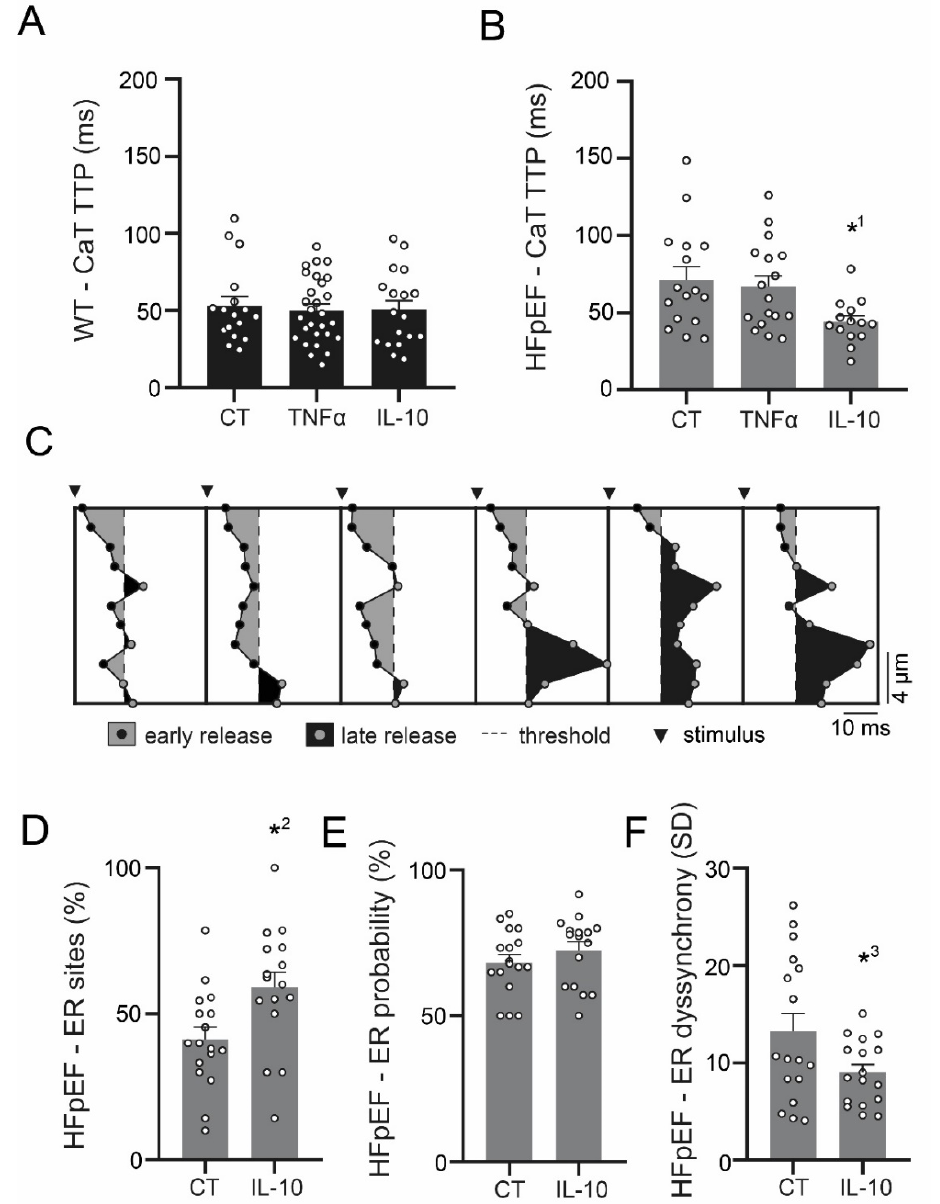
Figure 4. ( A ) CaT time-to-peak (TTP) of left atrial cardiomyocytes in WT and ( B ) HFpEF after 1 h incubation in Tyrode solution (CT), with additional TNF α or IL-10 (10 µ M, respectively). ( C ) Example visualization of early Ca 2 + release (ER) site analysis. ( D ) Corresponding data of fractional ER sites (E; > 3 ER events in 10 consecutive cycles). ( E ) Respective probability of ER of ER sites. ( F ) Standard deviation (SD) of ER sites as a measure of synchrony. Statistical analysis: One-way ANOVA, post-hoc Bonferroni ( A , B ) or student’s t -test ( D – F ). p -values: * 1 0.015, * 2 0.012, * 3 0.039. n -numbers indicate cells (from four animals per group).